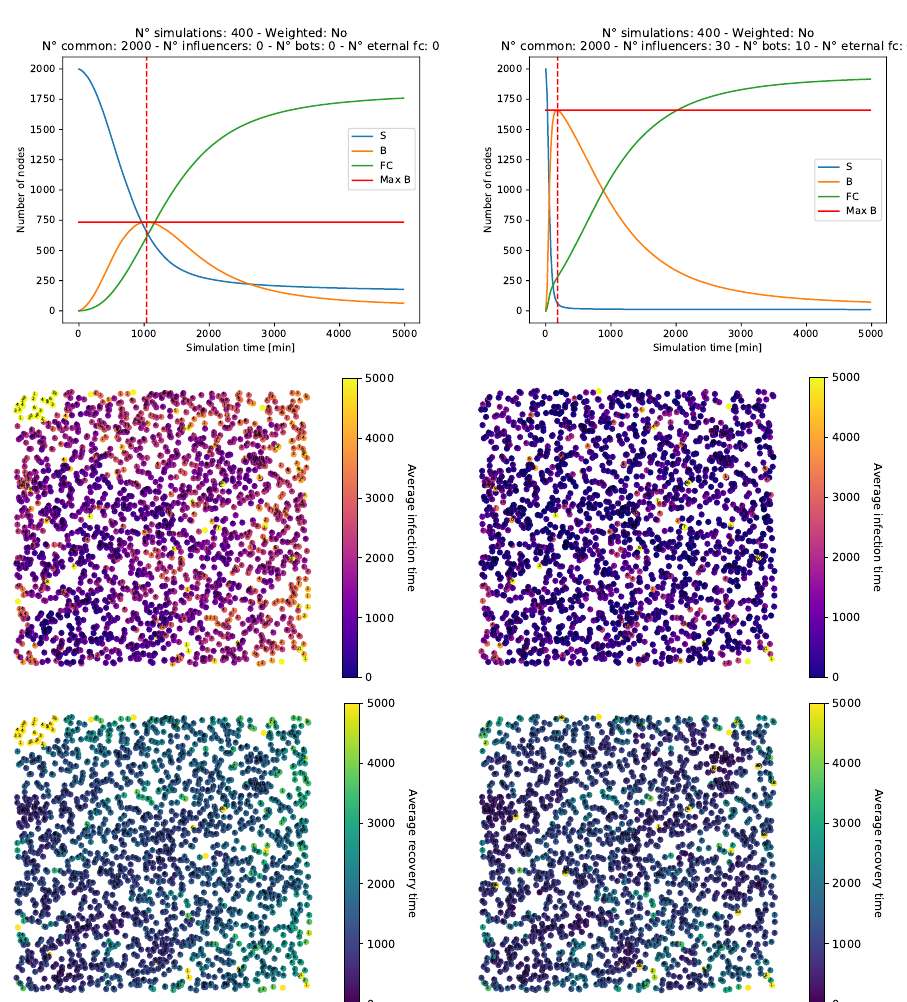
Figure 5. SBFC plots ( top row ), network infection graphs ( middle row ), and network recovery graphs ( bottom row ) for fake news spread in simulated online social networks (OSNs). ( Left ) Baseline network. ( Right ) Baseline network plus 30 influencers and 10 bots. In the middle row, the darker a node’s color is, the earlier that node starts believing in the fake news item. In the bottom row, the darker a node’s color is, the earlier that node performs